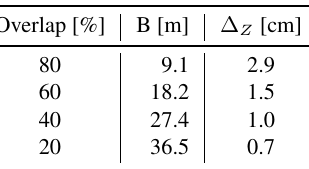
Table 1. Estimated height precision for planned